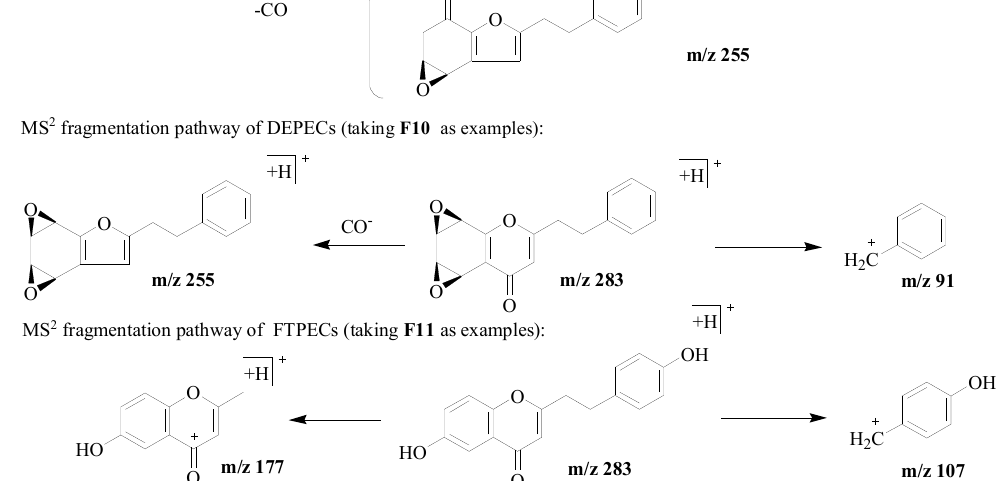
Figure 2. MS 2 fragmentation pathway of four types of chromones.